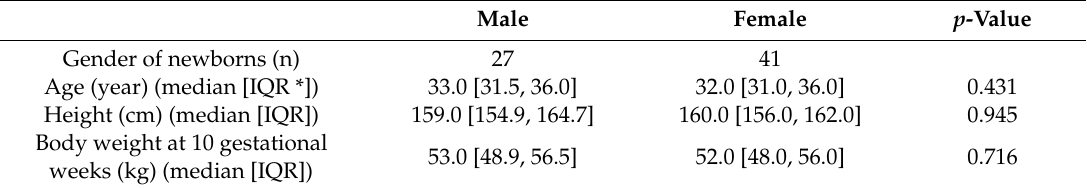
Table 2. Characteristics of mothers at Onodera Ladies Clinic (n = 68; data for gender of newborns, age, height and body weight at 10 gestational weeks were available).